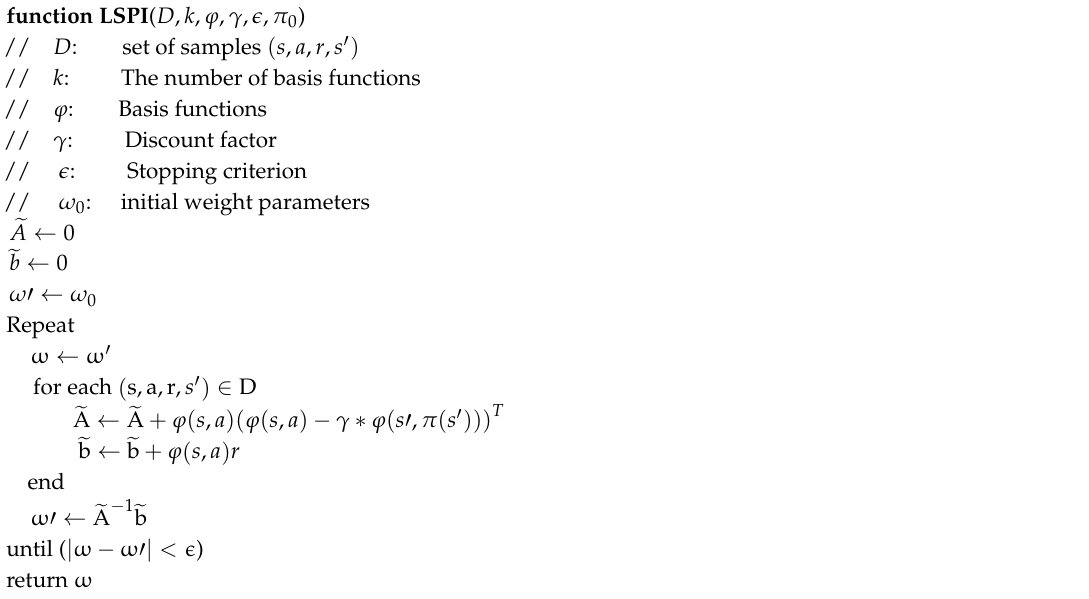
Algorithm 2 Pseudo-code of Least-Squares Policy Iteration (LSPI).